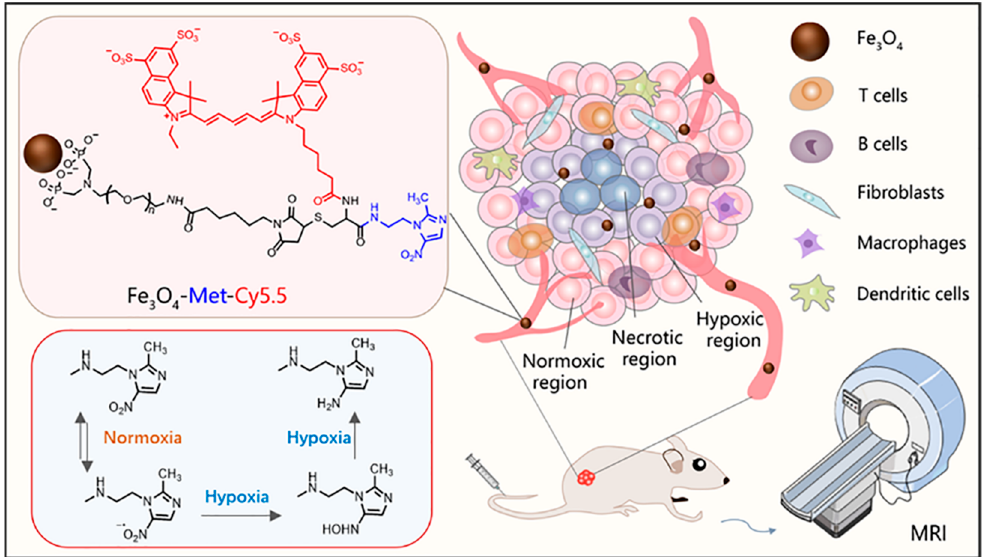
Scheme 1. The illustration of the Fe 3 O 4 -Met-Cy5.5 nanoprobe for in vivo T 1 -weighted MRI and the mechanism of metronidazole trapped in hypoxic